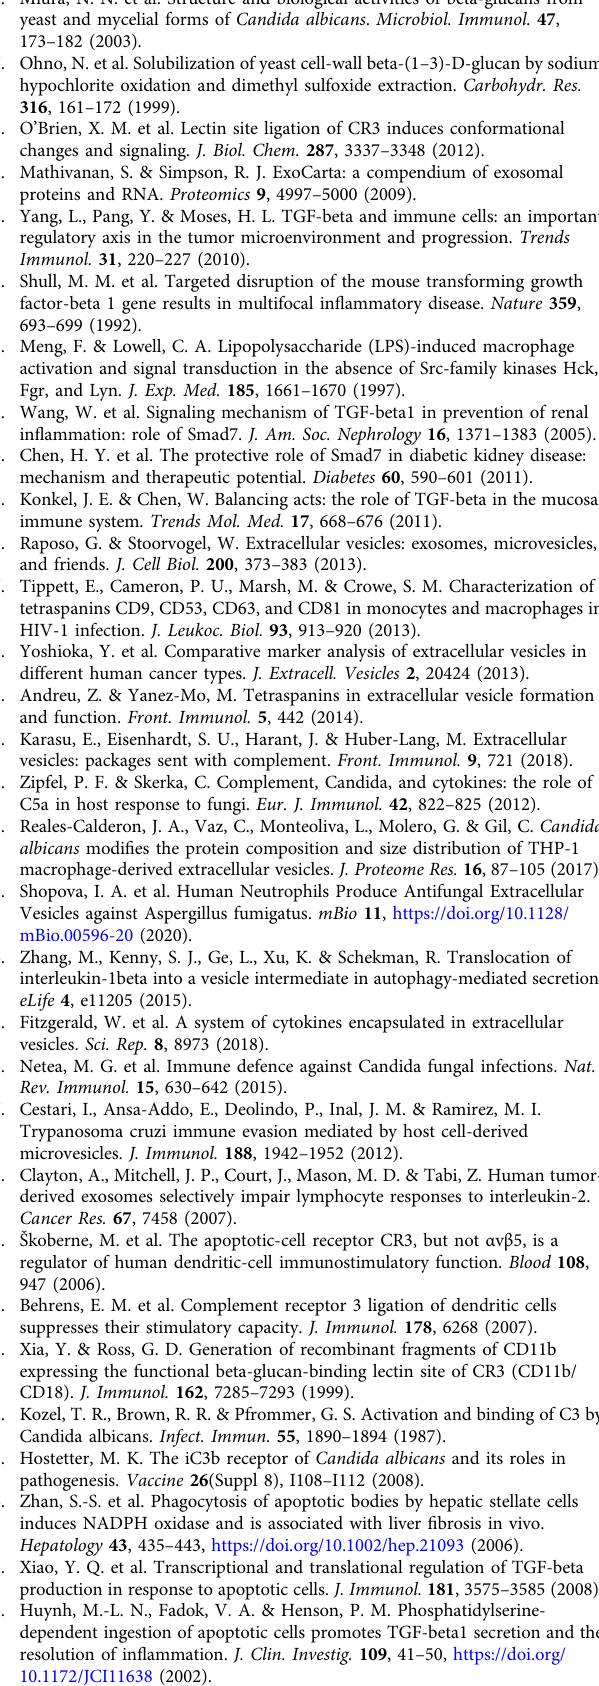
(1:1000) in nonreducing conditions (uncropped blot picture in Supplementary Fig. 7e). Factor H in mouse serum was detected using a sheep anti-mouse Factor H Antibody (R&D Systems, cat no. AF4999) (1µg/mL) and a rabbit anti sheep immunoglobulin-conjugated HRP secondary antibody (Dako, cat no. P0163)